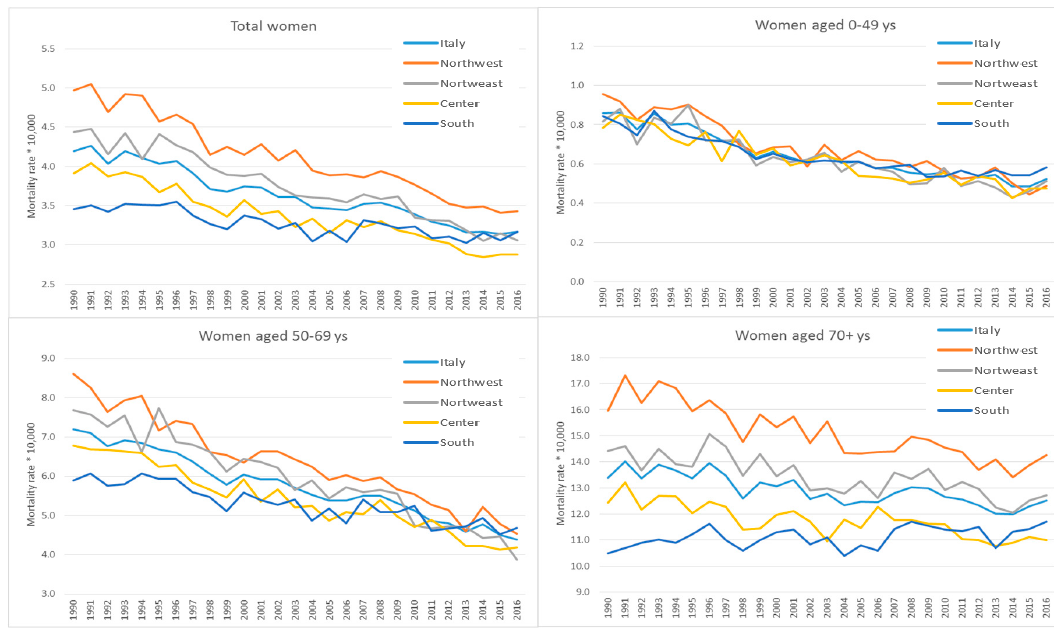
Figure 3. Age-standardised mortality rate for breast cancer in Italy overall and by age class and area of residence. Italy, 1990–2016. Source: National Causes of Death Register of the Italian National Institute of Statistics (Istat).